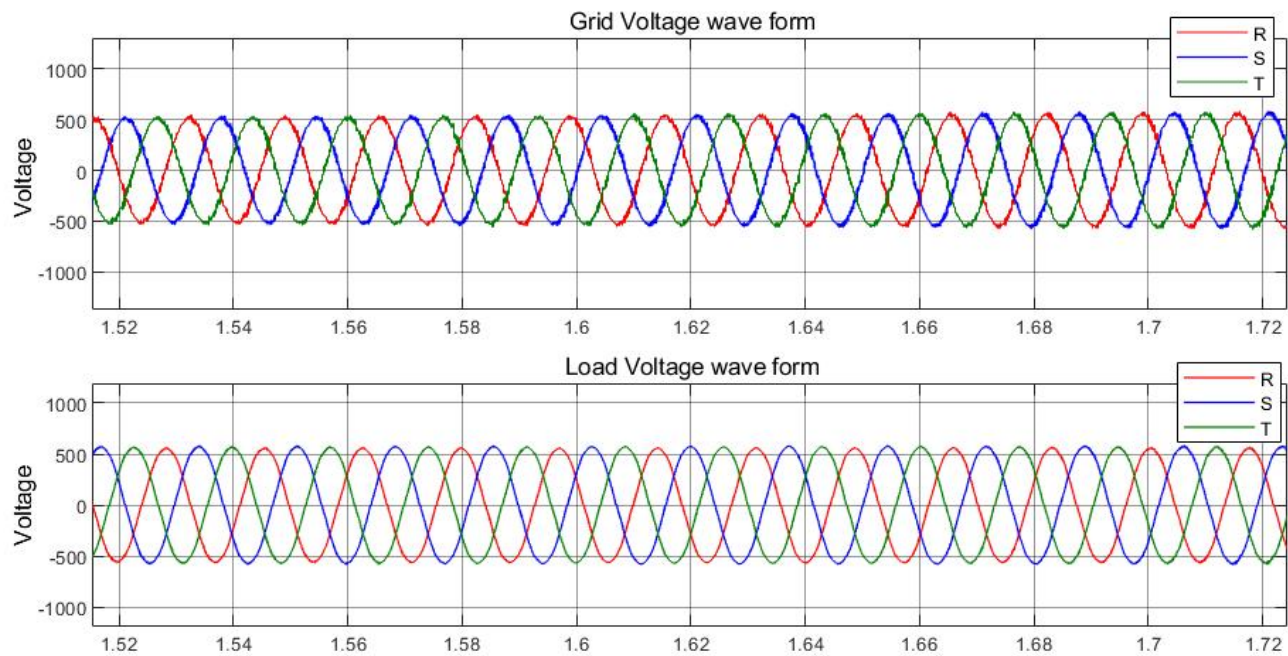
Figure 24. Load ‐ side and grid ‐ side voltage with non ‐ linear load on the load side using PWM. Figure 25 shows the grid-side voltage and load-side amplitude during the simulation.